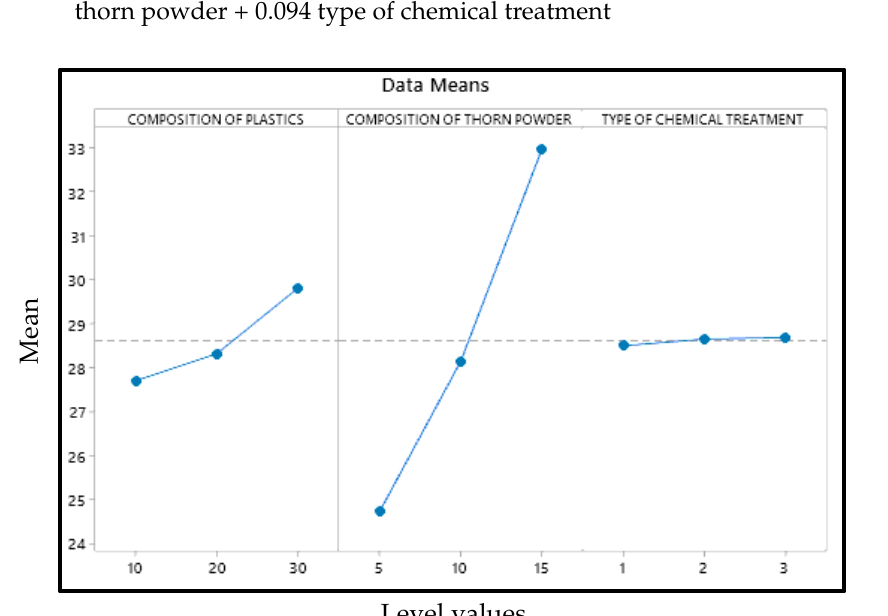
Table 3. Hardness ANOVA.